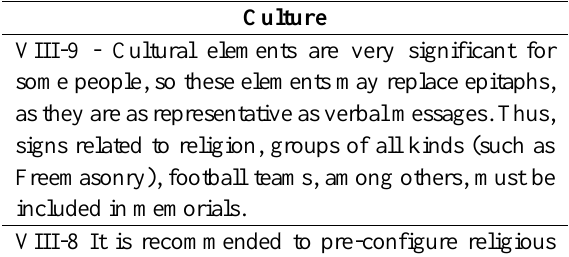
Table 3. Culture.